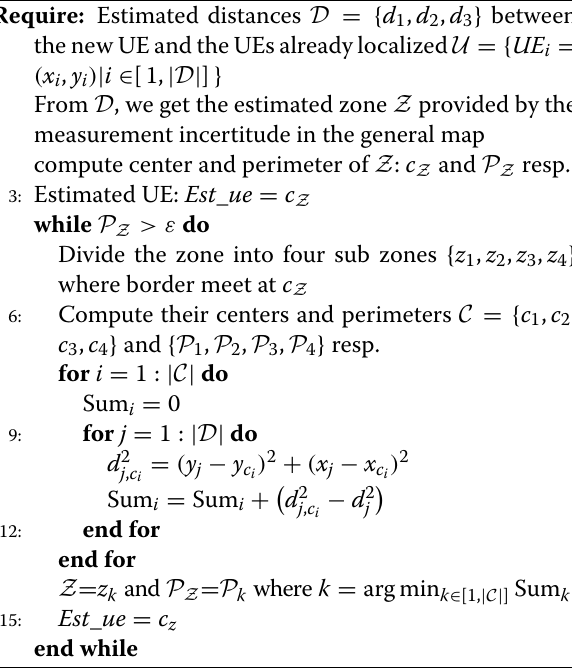
Algorithm 2 Map accuracy Fig. 12 Blind UE positioning accuracy applying Algorithm 2. This figure represents a location zone for blind UE after the optimization provide by Algorithm 2, where the yellow UEs are the estimated localization at each steps. The red one represents the blind